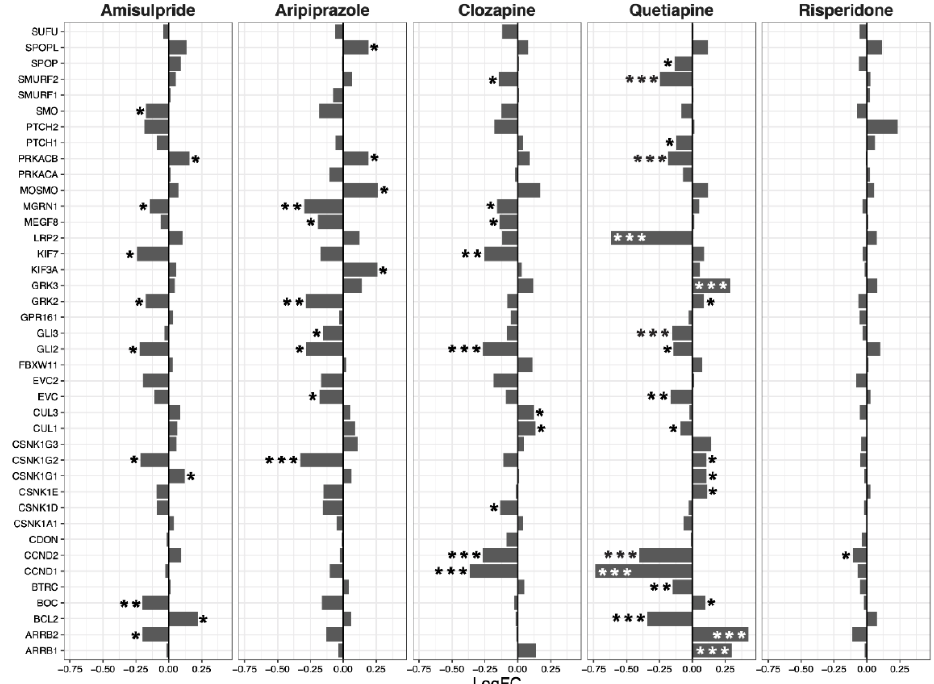
Figure 4. Hedgehog signaling pathway genes regulated by psychotropic drug treatment in NT2-N cells expressed as log fold change relative to vehicle-treated cells. * p < 0.05, ** p < 0.005, and *** p < 0.001.